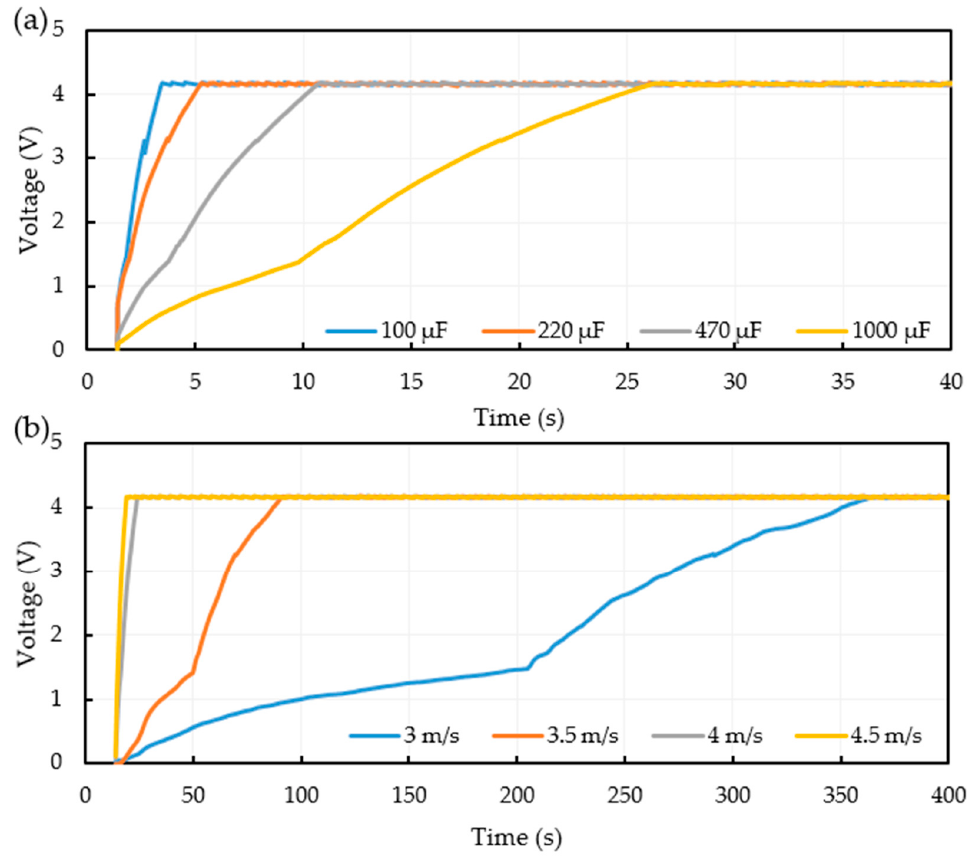
Figure 8. DC voltages (no load connected) over time ( a ) across different capacitors at 4.5 m/s wind speed and ( b ) across a 1000 µF capacitor at different wind speeds.